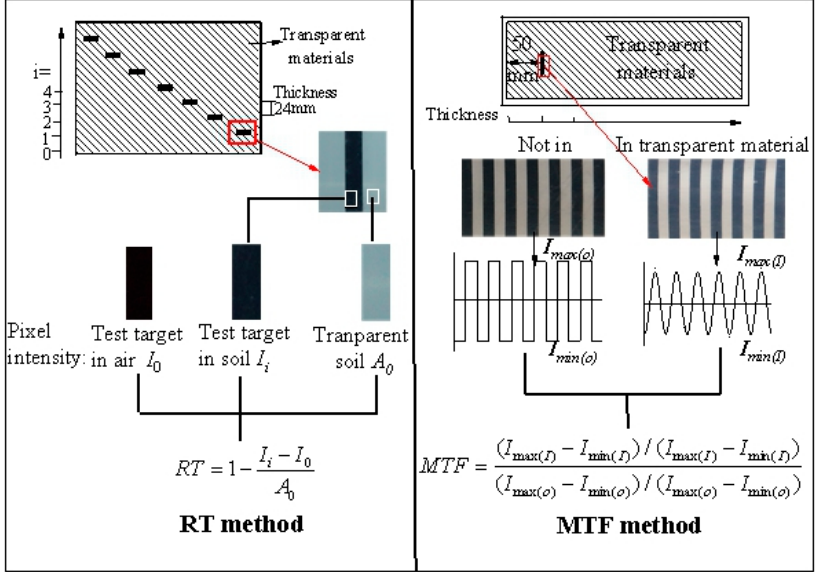
Figure 3. Calculation diagram: a-RT and MTF methods.